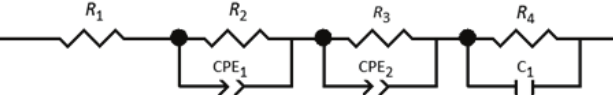
Fig. 2 – Equivalent circuit for steel corrosion in a saline solution with 100 µL of EEP and in a saline solution without EEP